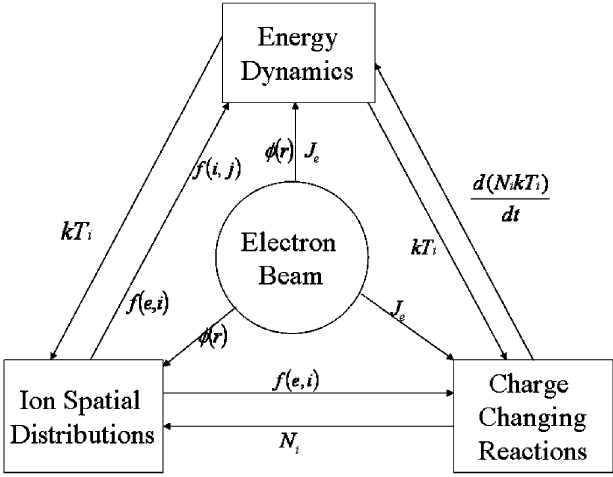
FIG. 1. An overview of the relationships between various processes occurring inside an EBIT